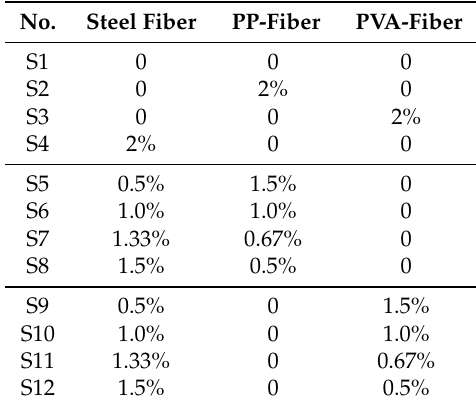
Table 3. Fiber volumetric content for